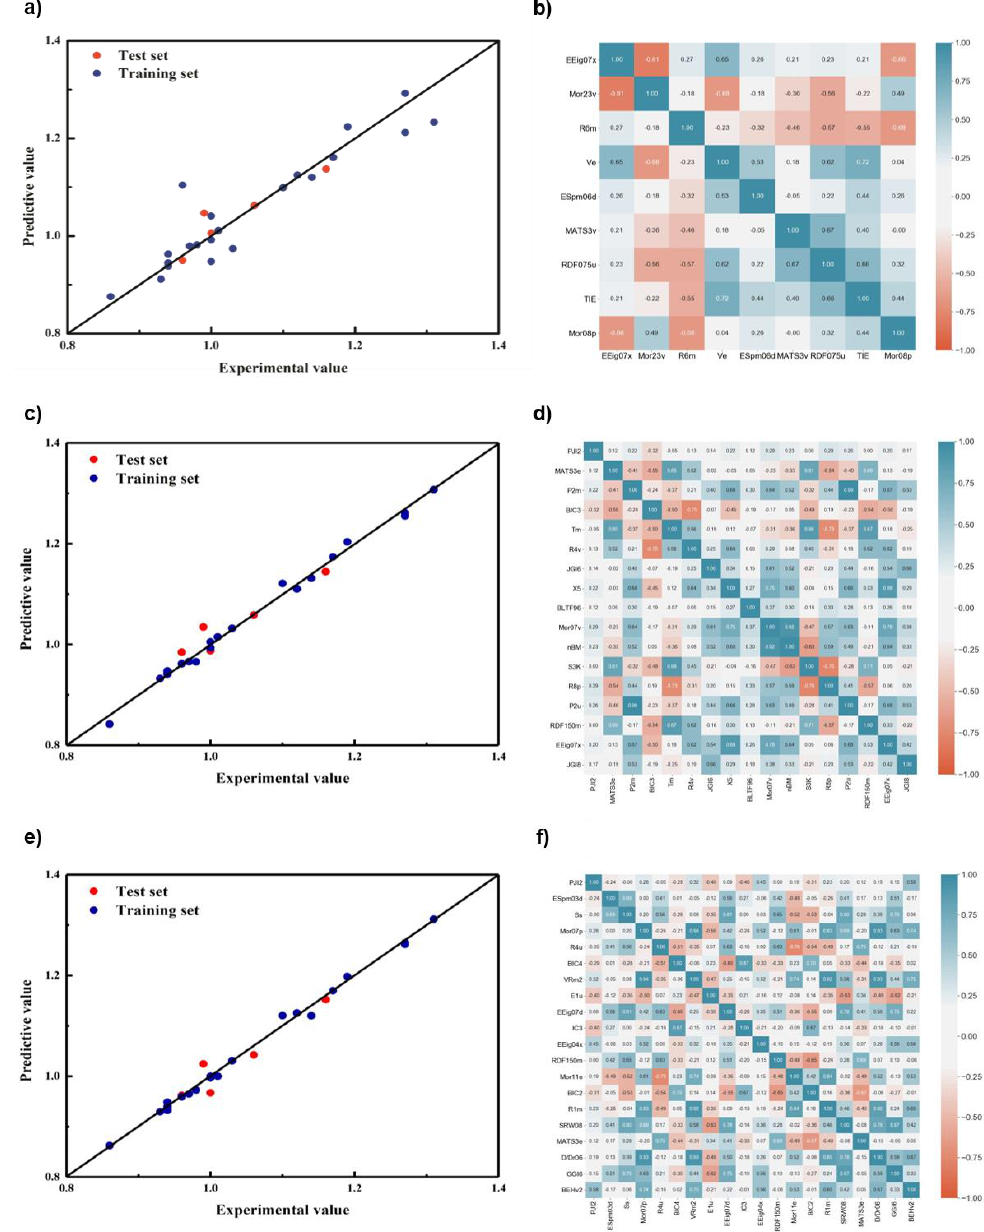
Figure 5. The prediction results of different regression models based on genetic algorithm and the correlation of descriptors. ( a ) And ( b ) GA-O; ( c ) and ( d ) GA-RE; ( e ) and ( f ) GA-REC. From the correlation results of descriptors, GA-RE finally chose PJI2, MATS3e, P2m, BIC3, Tm, R4v, JGI6, X5, BLTF96, Mor07v, nBM, S3K, R8p, P2u, RDF150m, EEig07x, and JGI8. GA 3.0 chose PJI2 ESpm03d, Ss, Mor07p, R4u, BIC4, VRm2, E1u, EEig07d, IC3, EEig04x, RDF150m, Mor11e, BIC2, R1m, SRW08, MATS3e, D/Dr06, GGI6, and BEHv2.